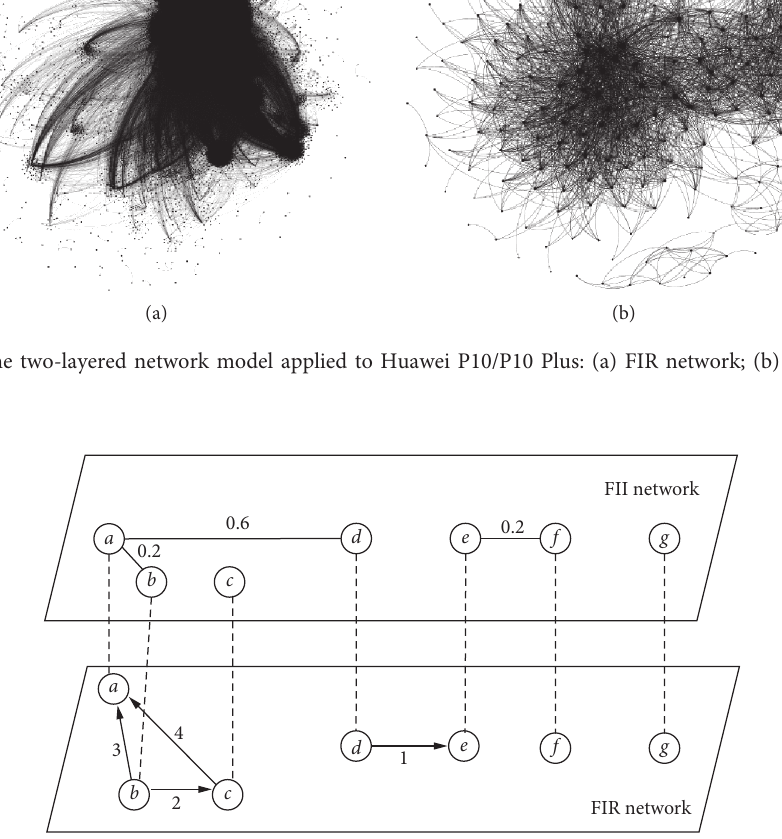
Figure 5: An example of FII and FIR networks.